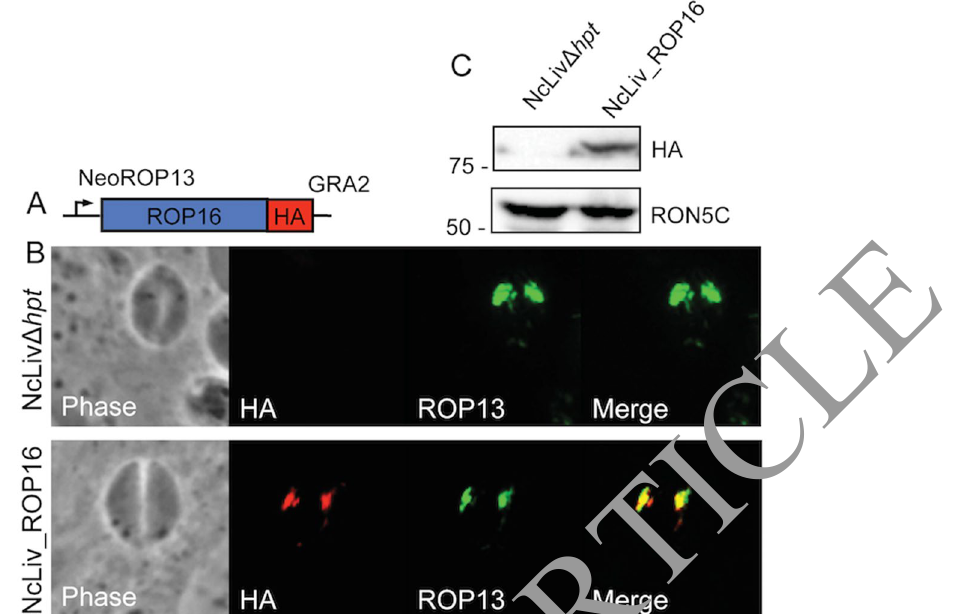
Figure 4. Expression of type I T. gondii ROP16 gene in N. caninum . ( A ) Diagram of the expression cassette encoding TgROP16 plus C-terminal 3xHA epitope tag, driven by the N. caninum ROP13 promoter, ( B ) expression of ROP16-expressing N. caninum tachyzoites confirmed by IFA. ROP16 was localized at the rhoptries by its HA tag, which colocalized with ROP13 marker. Red, rabbit anti-HA antibody; green, mouse anti-ROP13 antibody. Microscope magnification: 63x, ( C ) Expression of TgROP16 in transgenic N. caninum tachyzoites confirmed by Western blot. TgROP16 was detected by its HA tag present in the constructs driven by